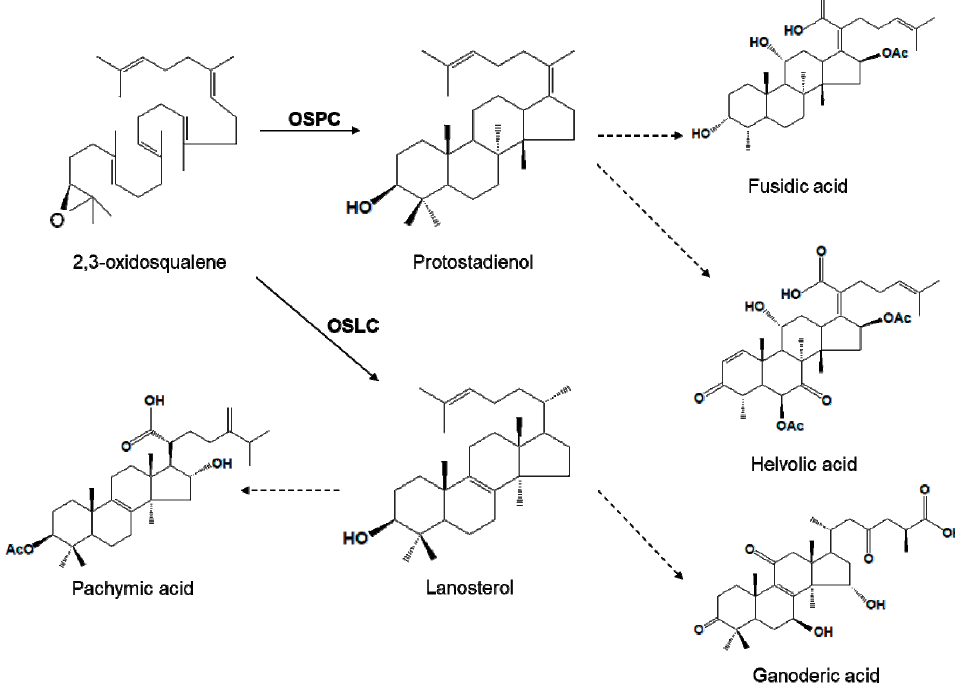
Figure 1. Putative biosynthesis pathway of steroidal triterpenoids in fungi. Dot arrows mean multiple steps.